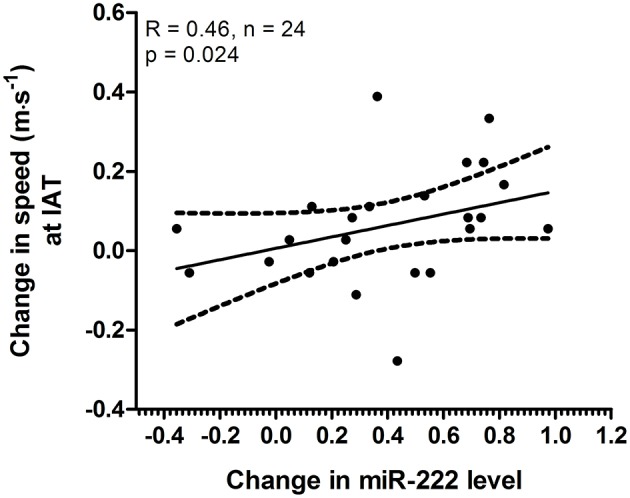
Acute changes in miR-222 at baseline were associated with increase in speed at individual anaerobic threshold (IAT). The analysis of acute changes of miR-222 levels within the 4 × 30 HIIT group at baseline showed a correlation with change in speed at IAT (baseline to follow-up). Individual data points are shown with 95% CI and linear regression.